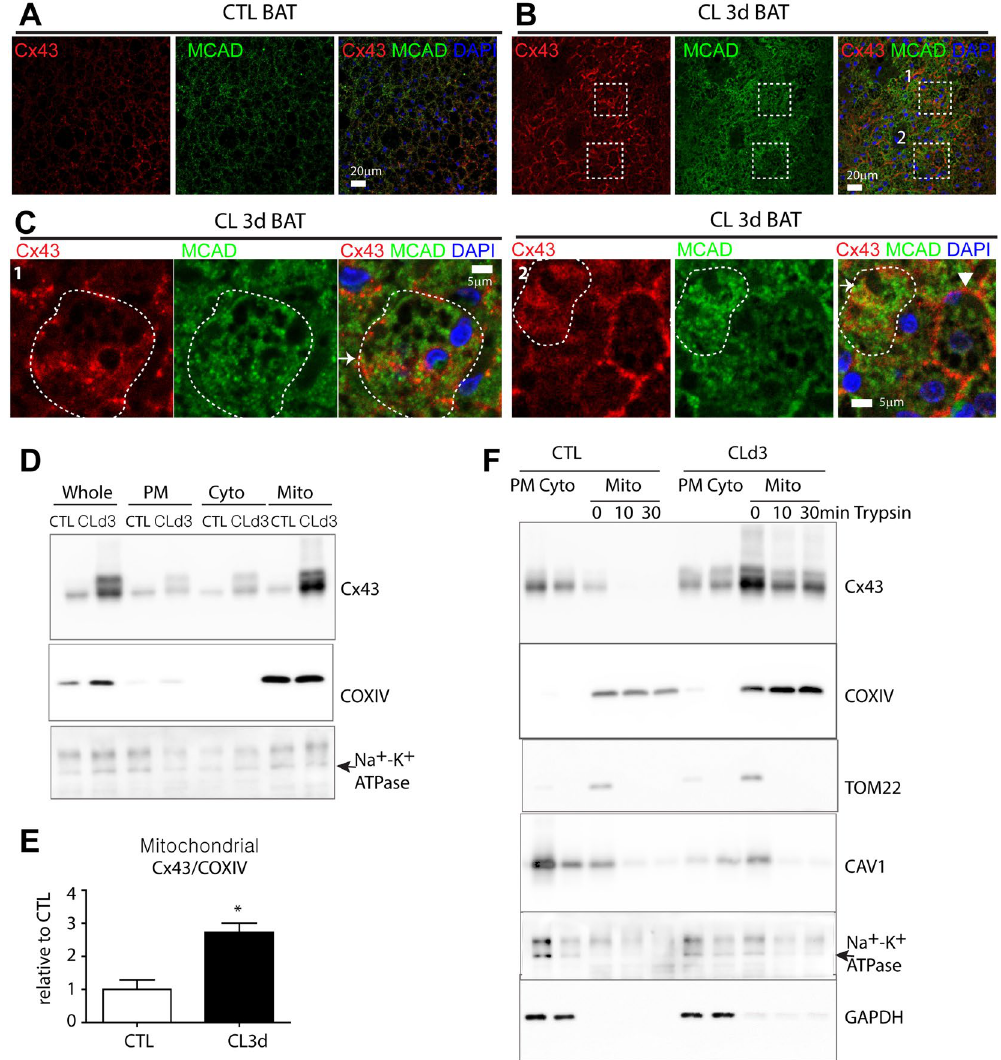
Figure 2. CL316,243 treatment increases mitochondrial localization of Cx43 in brown adipocytes. ( A–C ) Immunohistochemistry of Cx43 and MCAD in paraffin sections of BAT of mice treated with CL for 3 days and untreated controls. Nuclei were counterstained with DAPI. Bars = 5 or 20 μ m as indicated. Magnified images of boxed regions of ( B ) are shown in panel ( C ). Arrows indicate close association between Cx43 and MCAD, whereas arrowhead indicates Cx43 expression detected mainly in plasma membrane. ( D,E ) Immunoblot analysis and quantification of Cx43 expression in mitochondrial, plasma membrane and cytosolic fractions of BAT from mice treated with CL for 3 days and untreated controls. (Mean ± S.E.M. n = 3 per condition, * p < 0.05) ( F ) Immunoblot analysis of Cx43 expression in mitochondrial fractions treated with 0.05% trypsin. (Immunoblots accompanied by size markers in Fig.